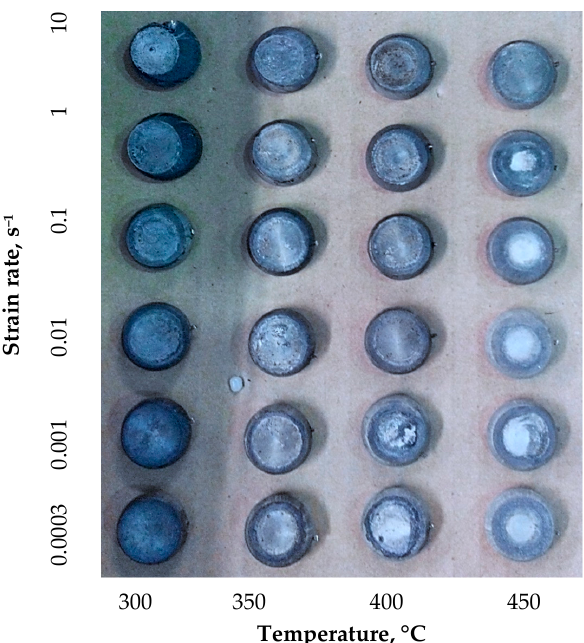
Figure 5. Shapes of deformed cylindrical specimens of DMD processed AZ31-3Ca alloy compressed at different temperatures and strain rates.